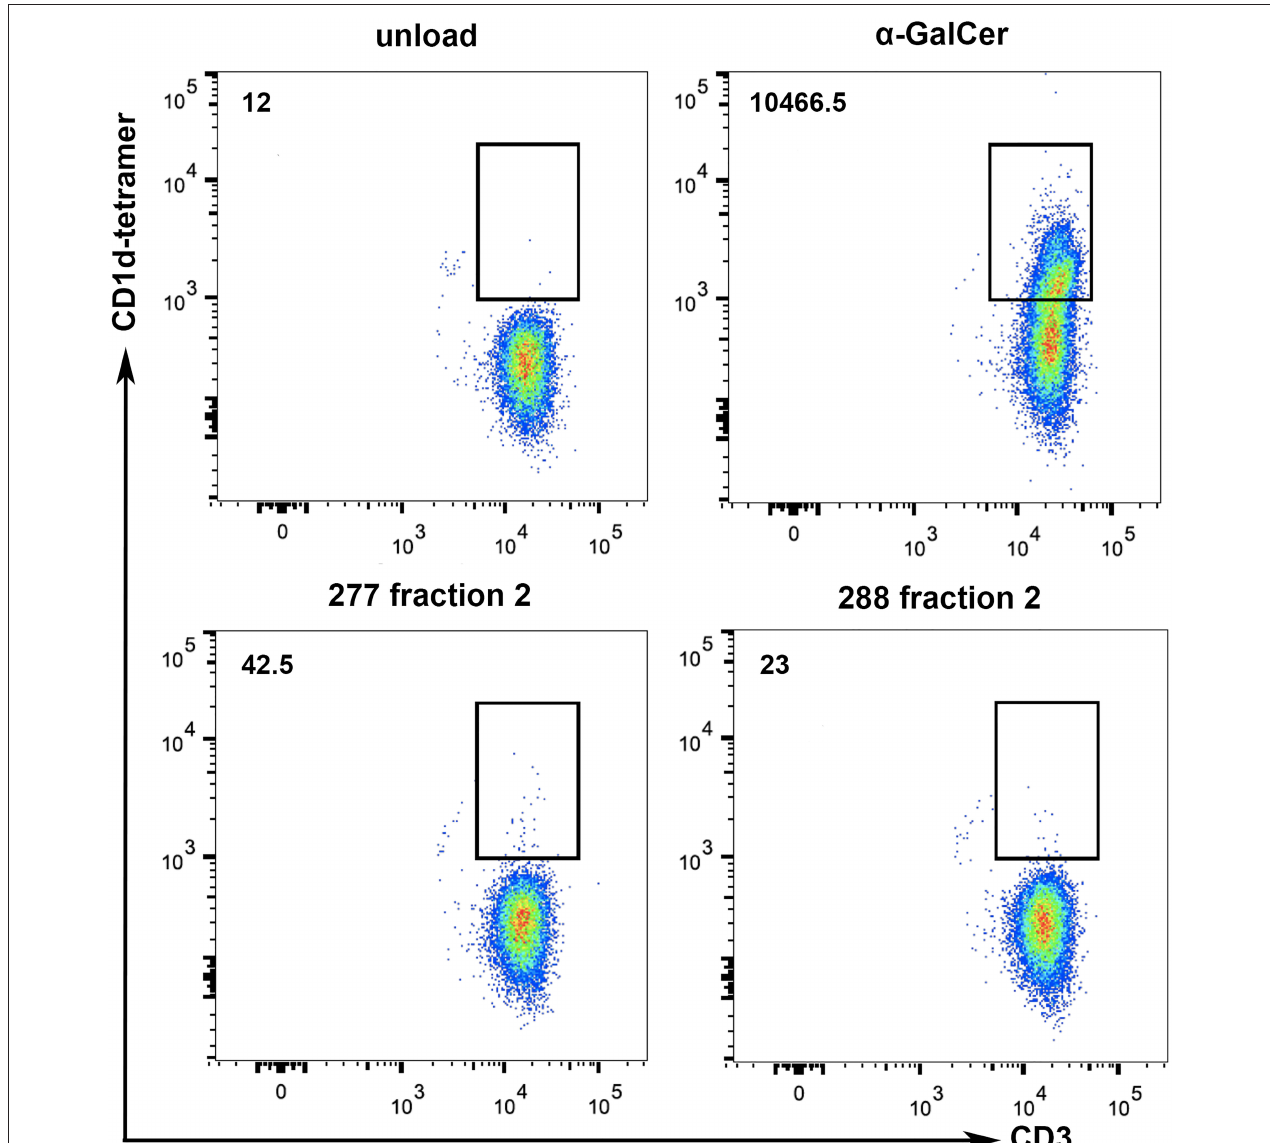
FIGURE 8 | Tumor lipids are presented to iNKT cells by CD1d. To show whether the stimulation of iNKT cells is dependent on CD1d specific lipid presentation, CD1d tetramer stainings with iNKT cells of two healthy donors were performed. α -GalCer-loaded CD1d tetramers were used as positive control and lipid-unloaded, vehicle-treated CD1d tetramers as negative control. Incubation of iNKT cells with lipid fraction (277 Fr. 2 and 288 Fr. 2) loaded CD1d tetramers reveal a small CD3 + CD1d-tetramer + population, indicating CD1d-specific presentation of tumor derived lipids. Numbers on the upper left represent the mean values of total CD3 + CD1d-tetramer + cells from the two